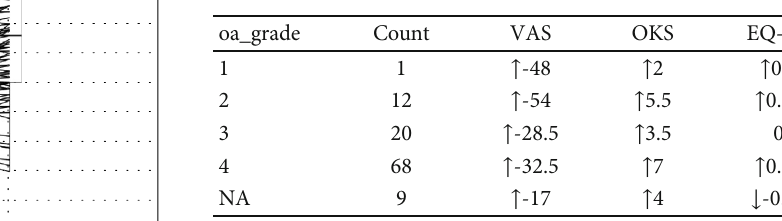
Table 1: Variation of median VAS, OKS, and EQ-5D between baseline and 12 months follow-up grouped by OA